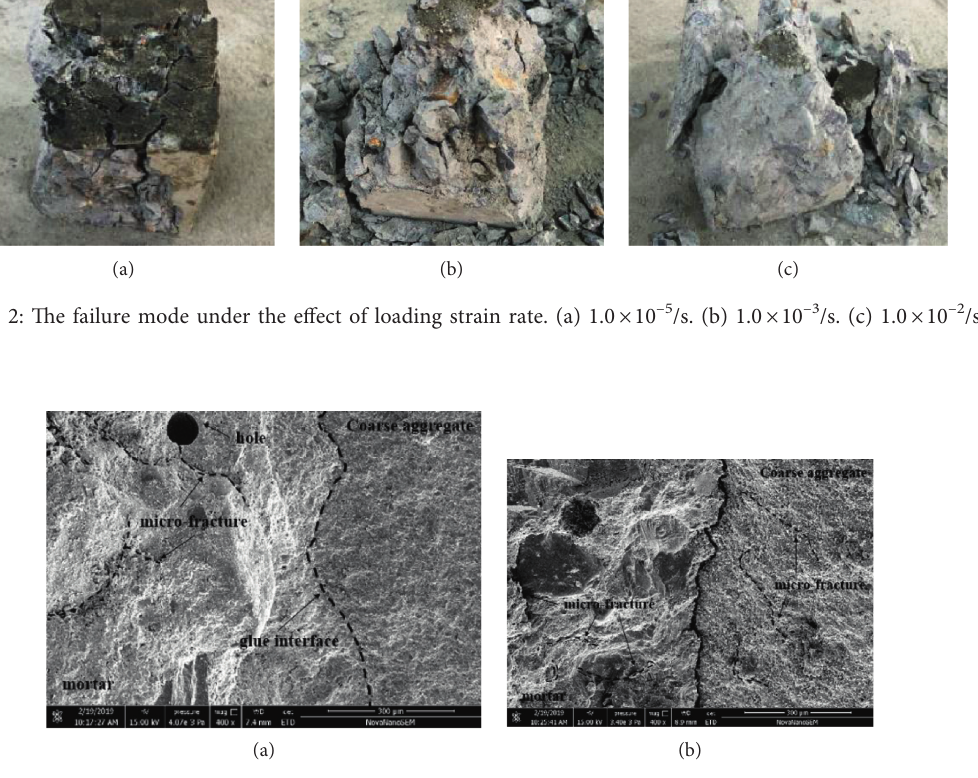
Figure 3: The SEM images of the failure NPCC at two different stain rates. (a) 1.0 × 10 –5 . (b) 5.0 × 10 –2